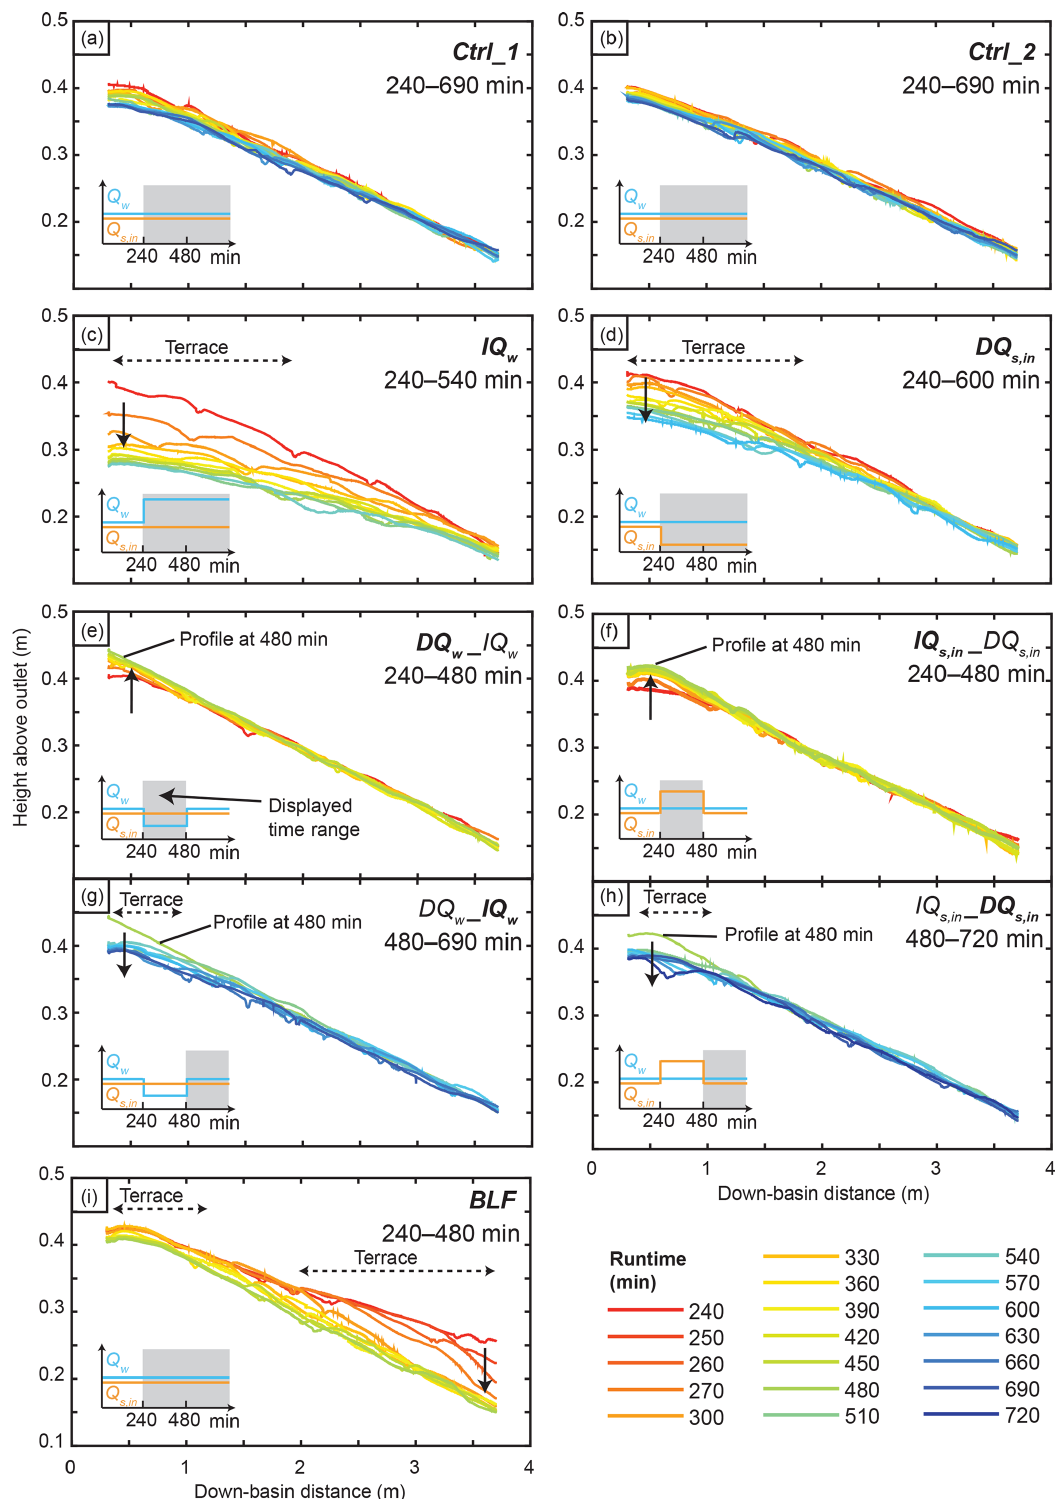
Figure 5. Evolution of longitudinal river profiles from minute 240 (end of spin-up phase) onwards. River profiles were extracted from the laser scans. Laser scans were recorded every 30min, and an additional two scans at 10 and 20min after the initiation of the base-level fall were conducted during the BLF experiment. Dashed arrows indicate the down-basin distance along which terraces formed. Solid arrows indicate modes of aggradation or incision. Note that the DQ w _IQ w and IQ s , in _DQ s , in were split into two panels each, with one panel representing each